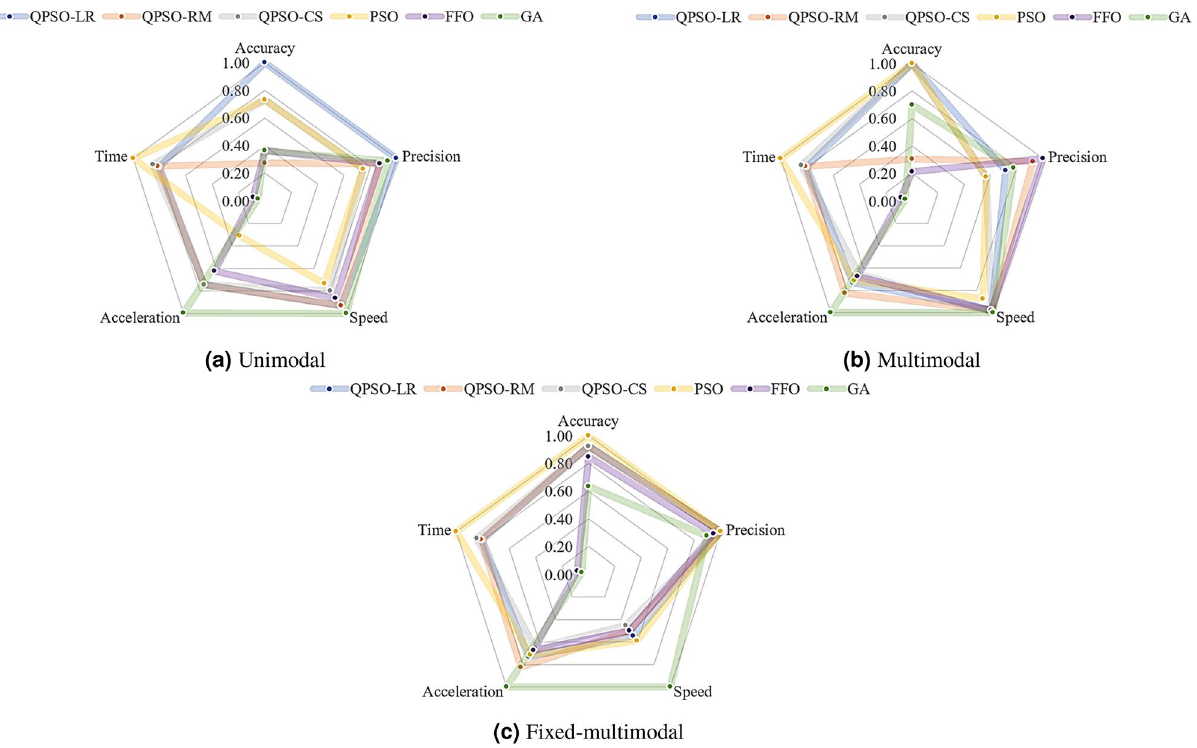
Figure 10. Optimization techniques performance categorized by type of